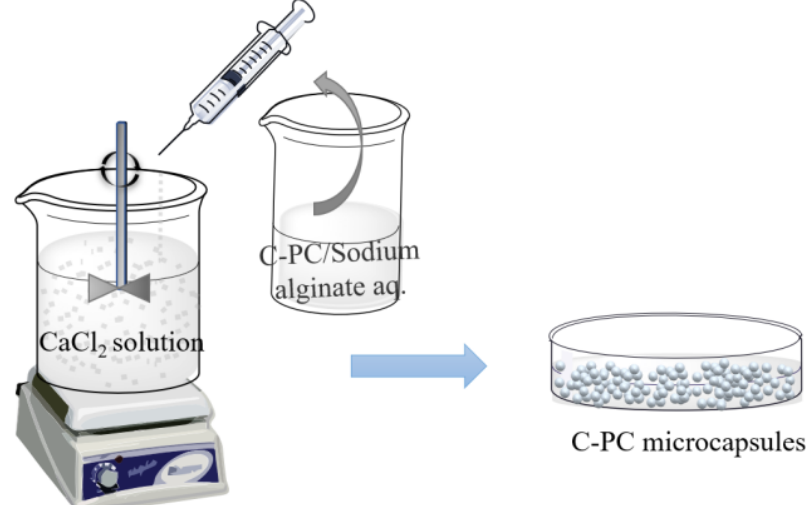
Figure 7. Schematic illustration showing the preparation of PC microcapsules using the sharp-hole coagulation bath